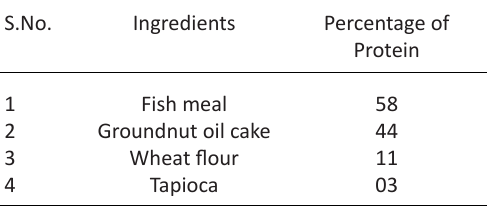
Table 1. Protein level of Major